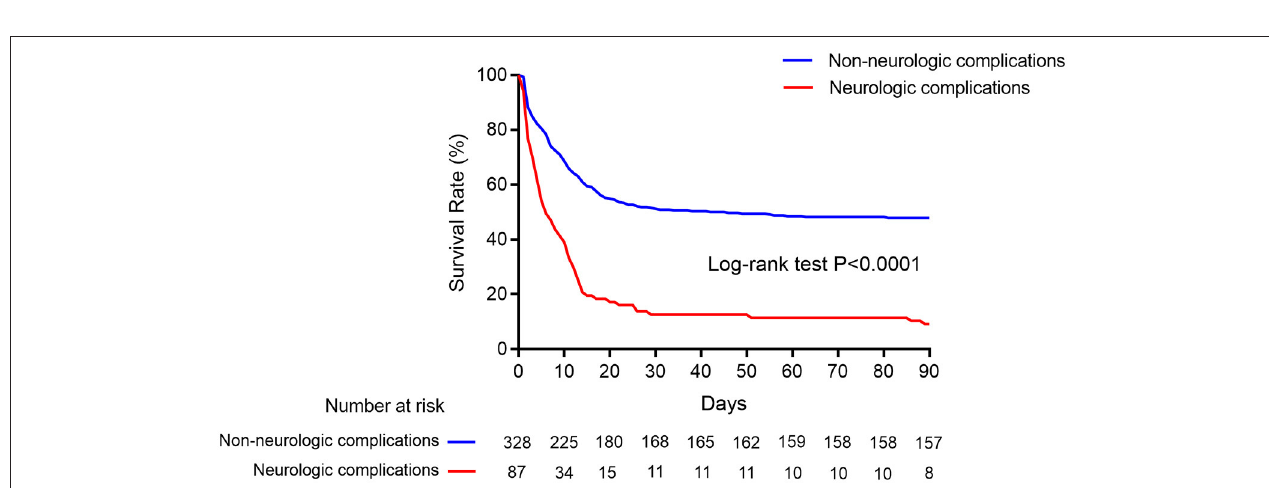
FIGURE 3 | Kaplan–Meier cumulative in-hospital mortality after ECMO initiation. Kaplan–Meier survival curves showed in-hospital mortality in ECMO patients with neurologic complications (red line) and without (blue line).